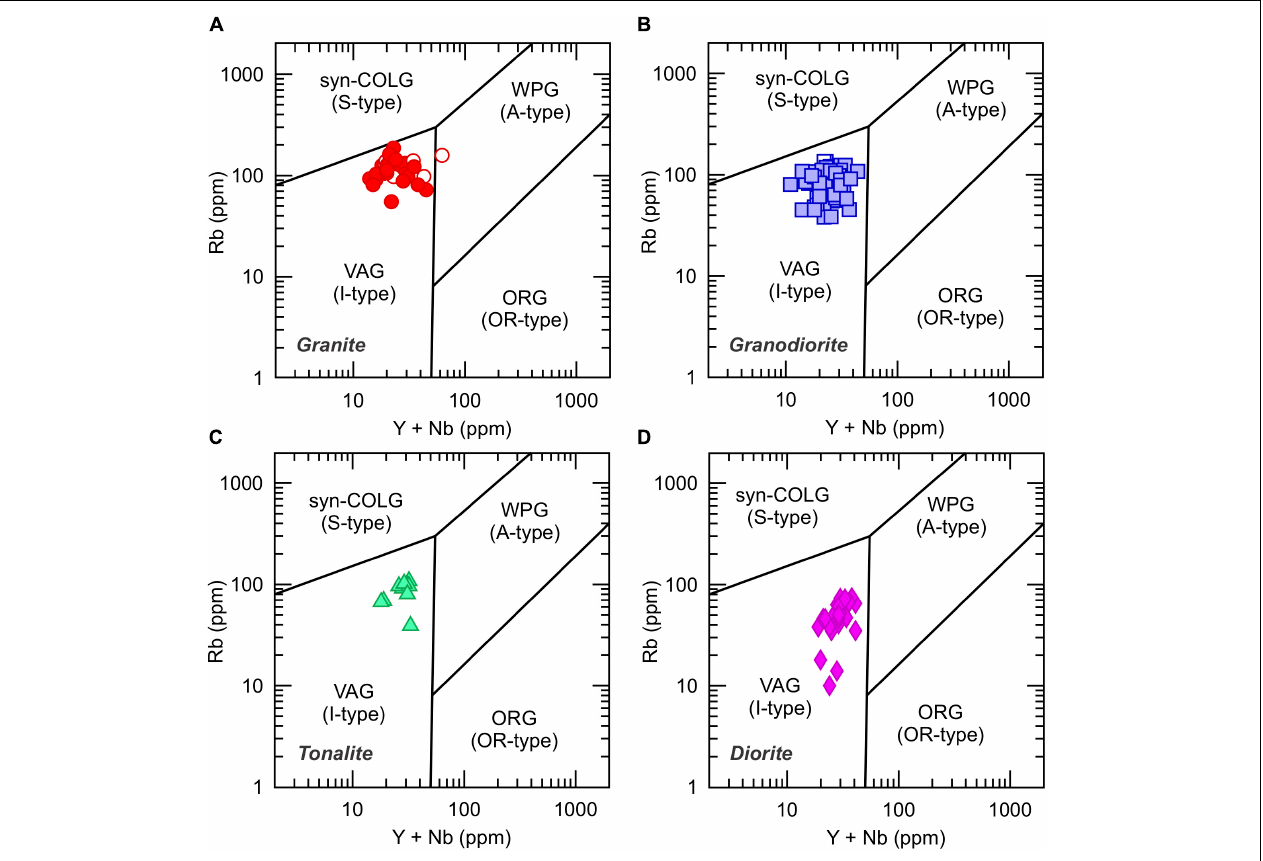
FIGURE 7 | Tectonomagmatic discrimination of the Cretaceous (A) granites, (B) granodiorites, (C) tonalites, and (D) diorites from Kyushu using Rb (ppm) vs. Y + Nb (ppm) criteria of Pearce et al. (1984) enhanced with Christiansen and Keith (1996). Symbols as in Figure 2 . VAG, volcanic arc granites; ORG, ocean ridge granites; syn-COLG, syn-collisional granites; WPG, within-plate granites; OR, ocean